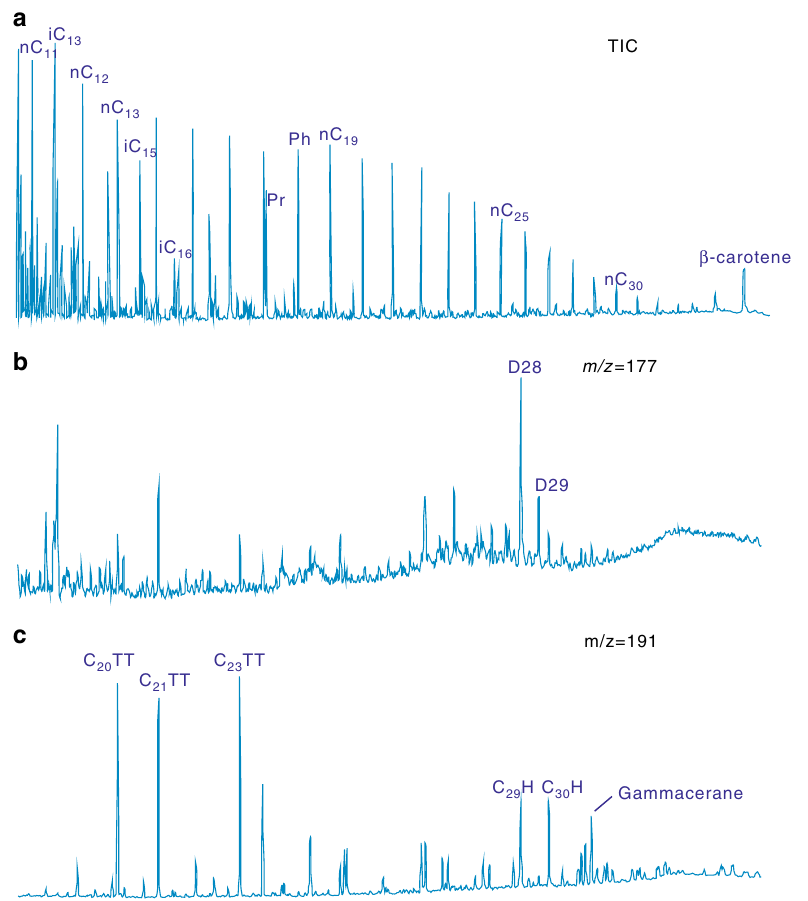
Fig. 5 Chromatogram and mass spectrogram of a representative T 1 b crude oil sample (No. M18-O-1). a In the total ion chromatogram (TIC) Pr and Ph indicate pristane and phytane, respectively. b D represents demethylated hopanes in the m / z 177 mass spectrogram. c TT is tricyclic terpane and H is hopane in the m / z 191 mass